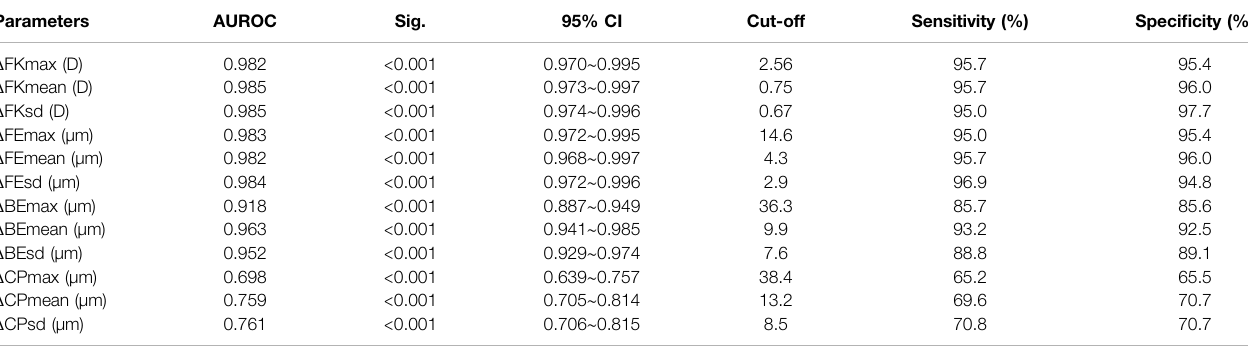
TABLE 3 | Diagnostic ef fi cacy of bilateral differential topographic characteristics. Parameters